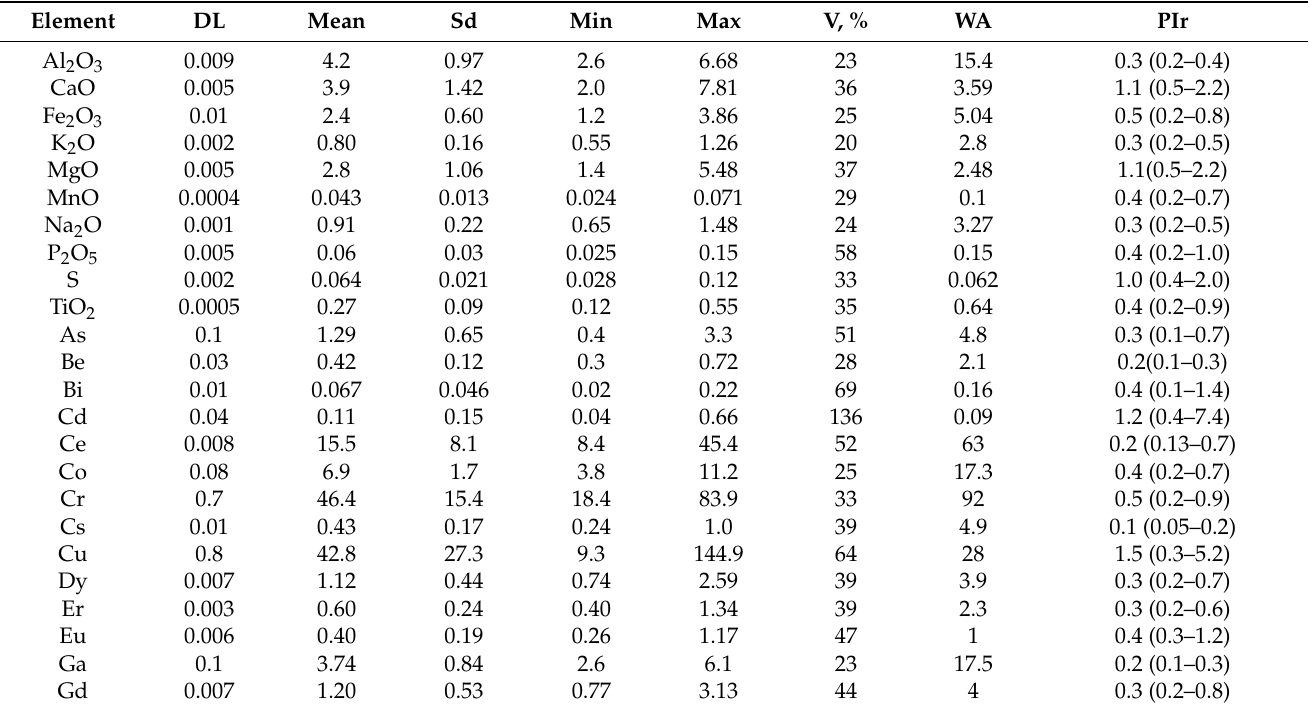
Table 3. Summary statistics for the contents of PTEs and other chemical elements in Surgut’s